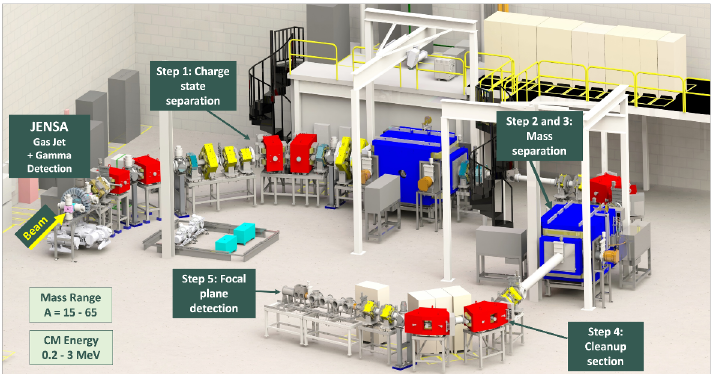
Figure 1. Beam enters SECAR through the JENSA gas jet target system (shown on the left of the picture), where the reaction takes place. γ -Rays, produced from the capture reaction, are detected at the JENSA chamber using an array of BGO detectors. Once a single charge state of the reaction recoils is selected (Step 1), it goes through a Wien Filter (WF1), where the unreacted beam ions are mass separated and eventually stopped using slits (Step 2). The remaining scattered beam particles are separated via the WF2 (Step 3), while the recoils go through a last “clean up” before reaching the detection system (Step 4) at the last focal